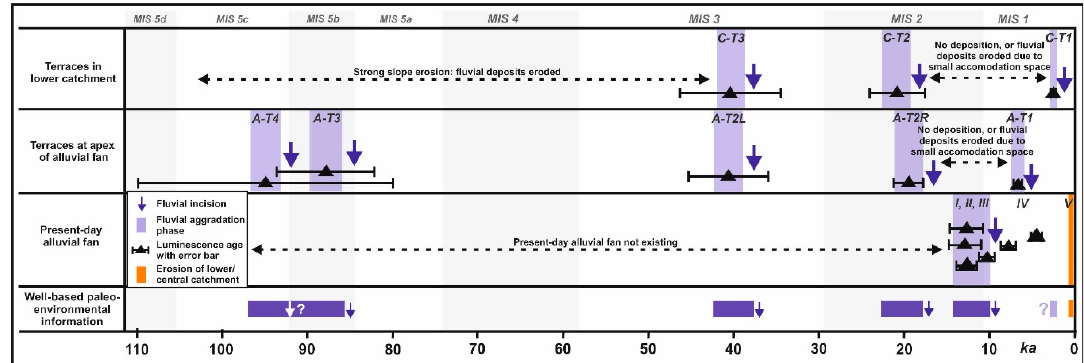
Figure 11. The late Quaternary fluvial dynamics in the three individually studied parts (upper part), and consequently derived well-based paleoenvironmental information from the total Kalshur river system (lower part). The latter represent fluvial aggradation phases that were independently identified in larger areas or in different parts of the river system, or are based on the observation of strongly increased proportions of boulders from the lower and central catchment.